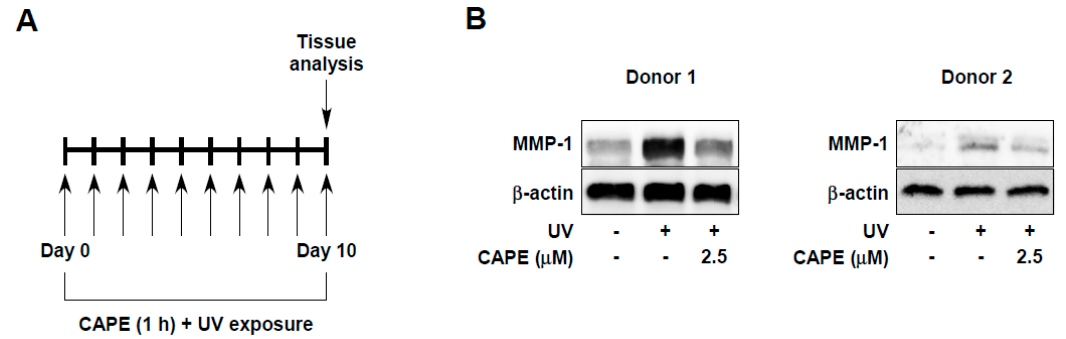
Figure 3. Effect of CAPE on UV-induced skin-wrinkle in ex vivo human skin tissue. ( A ) Human skin tissues were treated with CAPE at the indicated concentrations for 1 h, and then exposed to UV for 10 days. ( B ) MMP-1 protein expression was determined in human tissue lysate by immunoblotting. Skin tissues from two donors were